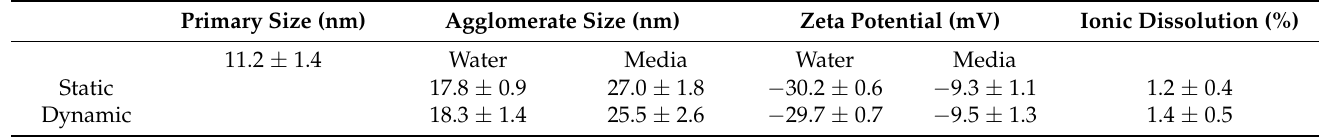
Table 1. AgNP characterization within multiple exposure environments.